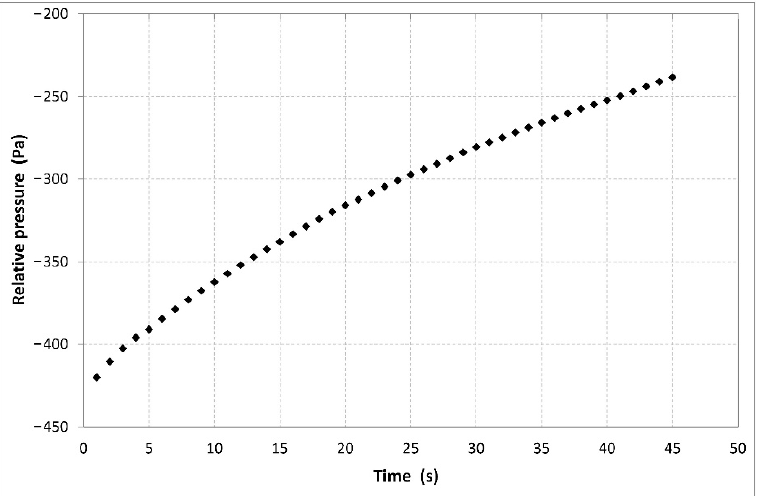
Figure 9. Curve of the changes in the pressure in the container over time during the measurement of